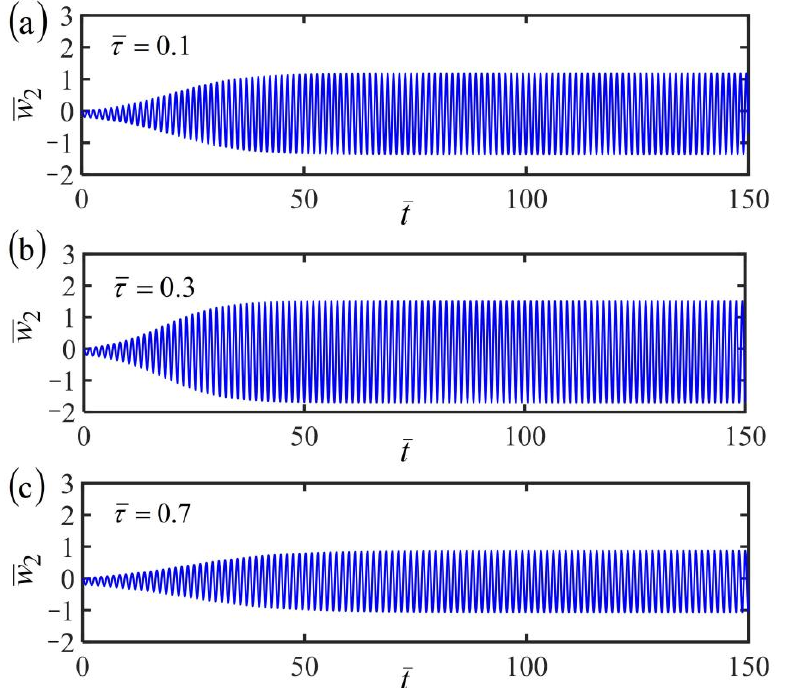
Figure 10. Time histories of the displacement of the fiber-mass system with a static frame in a linear temperature field for ( a ) finite characteristic times τ = 0.1, ( b ) τ = 0.3, and ( c ) τ = 0.7. The amplitude first increases and then decreases obviously with the increasing characteristic time.